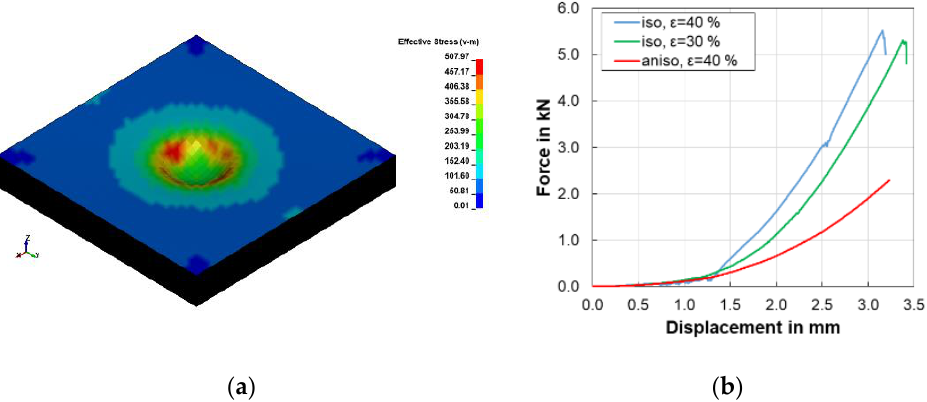
Figure 11. ( a ) Stress distribution on a deformed battery cell after indentation simulation. ( b ) Force- displacement outputs of isotropic and anisotropic models with the heterogeneous modelling method.